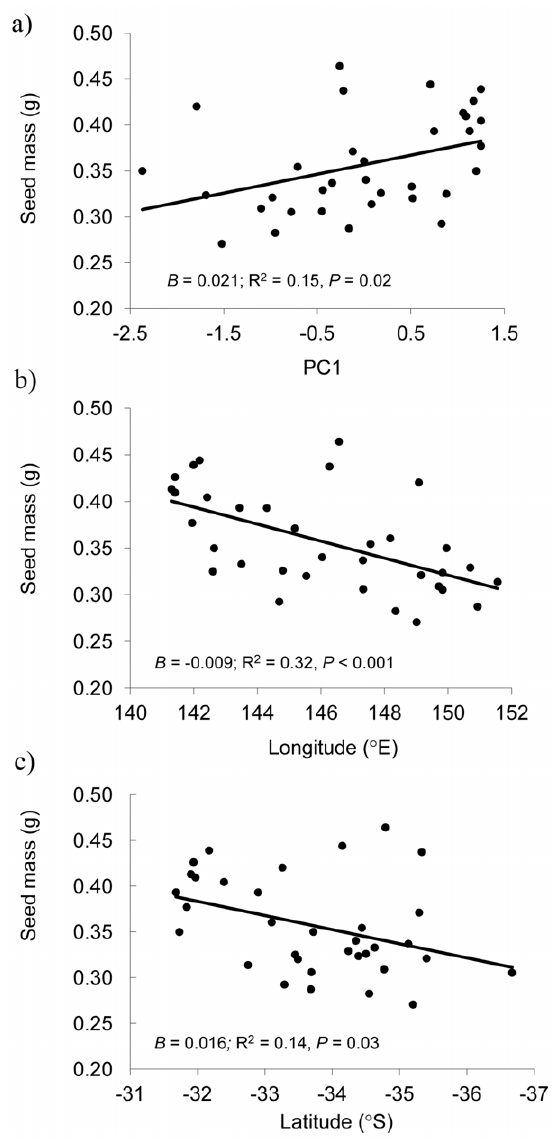
Figure 4. Seed mass and seed mass variance derived from plants collected from six bioregions in the study area. (a) Mean site-level seed mass (g; 100 seeds) across all six bioregions based on the final data set (with small seeds removed). Site means are shown as filled circles while bioregion means (average of all sites within a bioregion) are shown as unfilled circles. (b) Estimated mean seed mass ( 6 1 SE) for each bioregion based on linear mixed model analysis (see methods) of final data set (square root transformed). Means sharing the same letter did not differ significantly at the 0.05 level. (c) Variance in seed mass for all study sites in each bioregion, determined as the variance in seed mass among seed-producing plants using the final data set. Abbrevi- ations denote the individual bioregions, See Fig. 1 for full names. Bioregions are arranged along the x axis from most westerly (BHC) to most easterly (COAST).